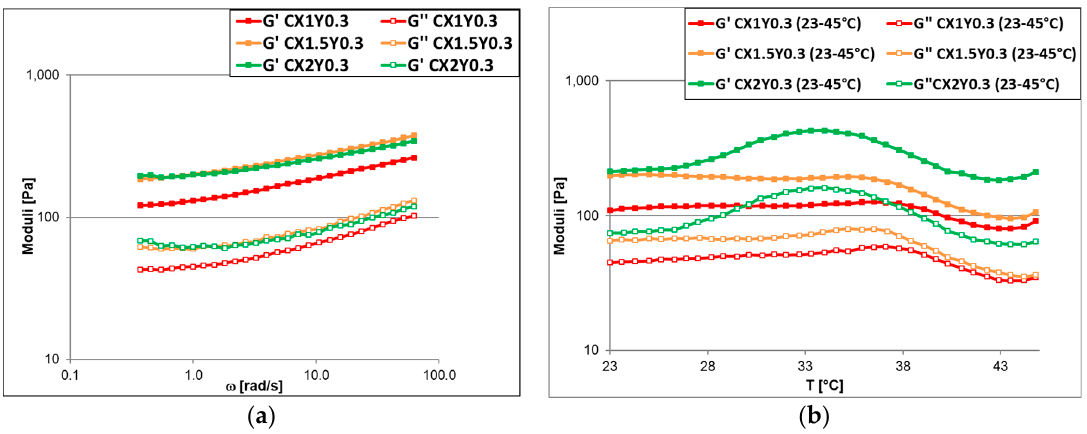
Figure 6. ( a ) G ′ and G ″ as a function of frequency and ( b ) of the temperature of samples containing 0.3% of Cosmedia ® SP and added with different concentrations of Bosexil ® (1%,1.5%, 2%).